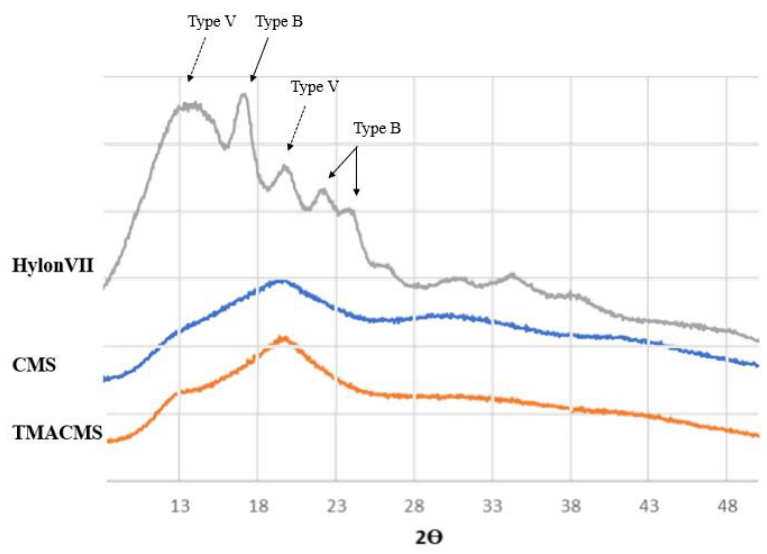
Figure 4. X-ray diffraction patterns of Hylon VII, CMS, and TMACMS. The diffractograms of CMS and TMACMS exhibit larger less-ordered zones (V-type), whereas the more crystalline zones (B-type) are decreased.